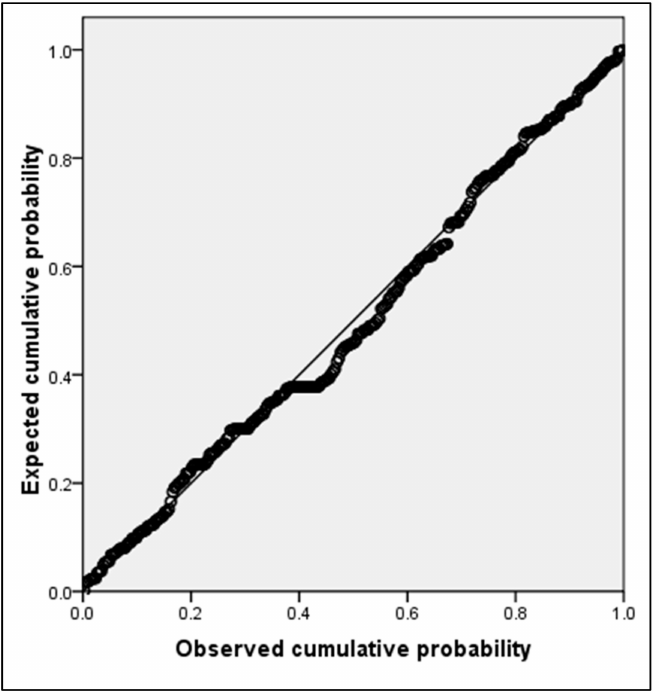
Figure A4. Normal P-P plot of regression standardized